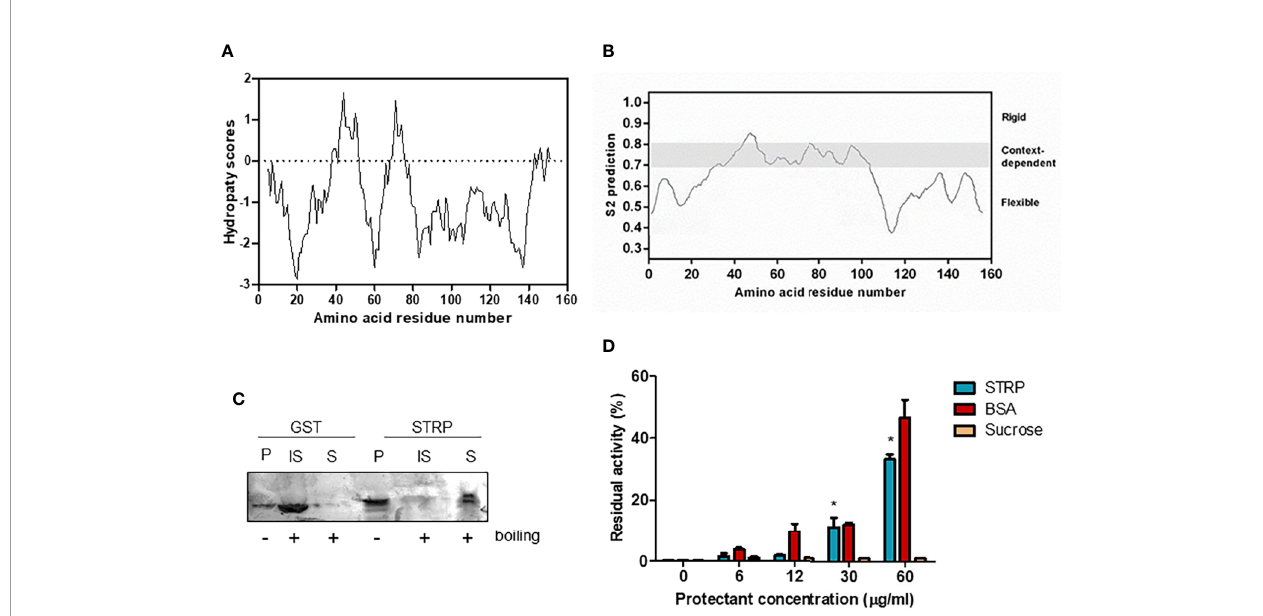
FIGURE 3 | STRP physicochemical properties. (A) hydropathy plot of STRP. The analysis was performed by using Kyte – Doolittle values (Kyte and Doolittle, 1982) with a window size of 9. Negative values indicate the predicted hydrophilic regions. (B) prediction of STRP folding with DynMine system (Cilia et al., 2013). (C) STRP solubility after boiling. Recombinant STRP and GST were treated (+) or not ( − ) for 20 min at 100° C, cooled and separated by SDS-PAGE. P, puri fi ed protein; IS, insoluble fraction; S, soluble fraction. (D) STRP cryoprotection assay on LDH. LDH was frozen for 24 h at − 20° C in presence of different concentrations of cryoprotectants. The enzyme was thawed on ice and the residual activity, expressed as a percentage of enzyme initial activity before the freeze-thaw cycle, measured at 340 nm. Error bars are S.E.M. of three independent experiments. *P < 0.01, by Student ’ s